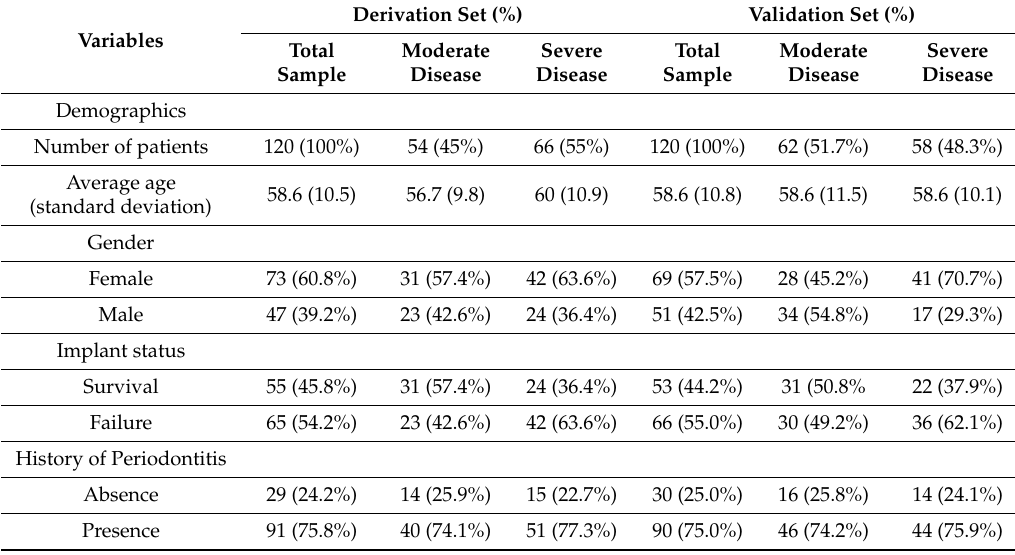
Table 1. Sample characteristics in the derivation and validation sets of patients with Peri-implant disease (total, moderate disease and severe disease thresholds). Percentages are indicated according to